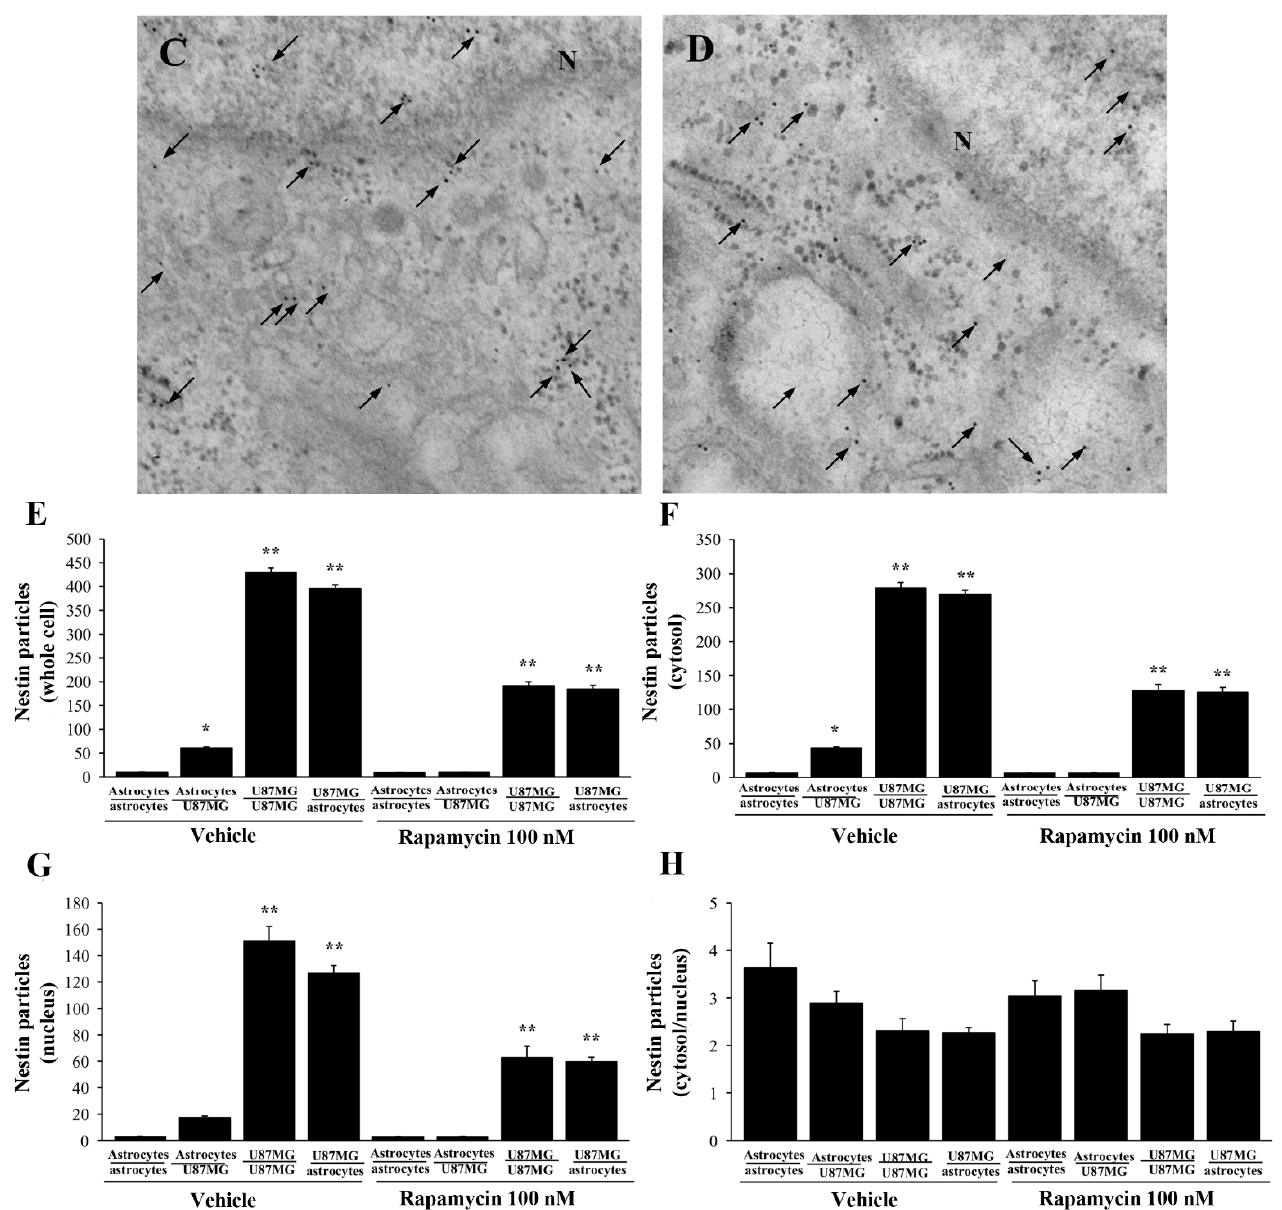
Figure 14. Rapamycin reduces nestin immuno-gold particles within astrocytes co-cultured with GBM cells. Representative micrographs show nestin immuno-gold particles within both the cytosol and nucleus (black arrows) of astrocytes co-cultured with astrocytes treated with rapamycin ( A ), astrocytes co-cultured with GBM cells treated with rapamycin ( B ), GBM cells co-cultured with GBM cells treated with rapamycin ( C ), and GBM cells co-cultured with astrocytes treated with rapamycin ( D ). N = nucleus. Ultrastructural stoichiometry of nestin immuno-gold in co-cultures of astrocytes and GBM cells following rapamycin administration is reported in the graphs. In detail, graphs report the number of nestin immuno-gold-particles within whole cell ( E ), cytosol ( F ), and nucleus ( G ). The ratio of nestin immuno-gold particles within cytosol vs. nucleus is reported in ( H ). Data are given as the mean ± S.E.M. from N = 30 cells per each experimental group. * p < 0.05 compared with astrocytes co-cultured with astrocytes, ** p < 0.05 compared with astrocytes co-cultured with GBM cells. Scale bar = 0.12 µ